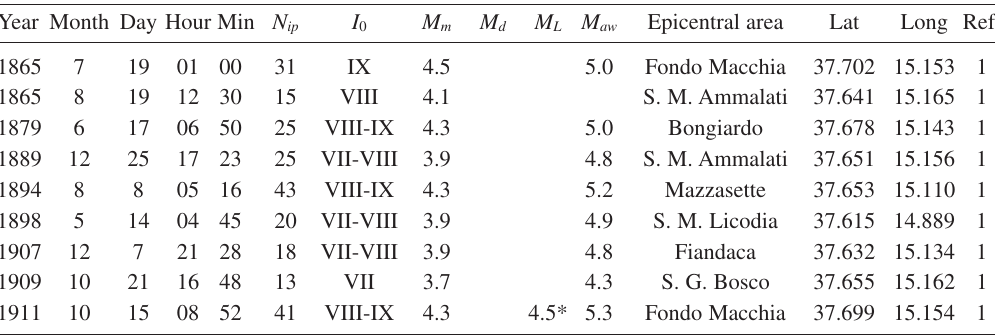
Table I. Dataset of the earthquakes selected for the Etna area. N ip , number of intensity data points; I 0 , epicen- tral intensity; M m , macroseismic magnitude, calculated by the intensity-magnitude relationship from Azzaro and Barbano (1997); M aw , moment magnitude from CPTI Working Group (2004); ∗ magnitude from surface waves Ms (Margottini, 1993). Source of data: 1) Azzaro et al . (2000); 1a) Azzaro et al .